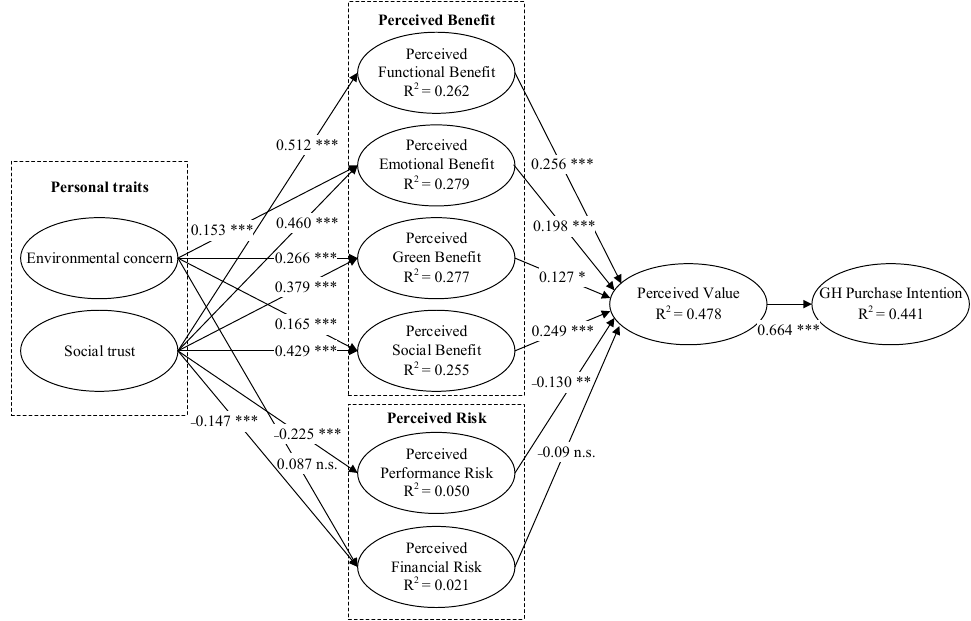
Figure 2. Results of hypothesis testing. Note: * p < 0.05; ** p < 0.01; *** p < 0.001, n.s. nonsignificant. Table 5. Path analysis and significance verification of the structural models.